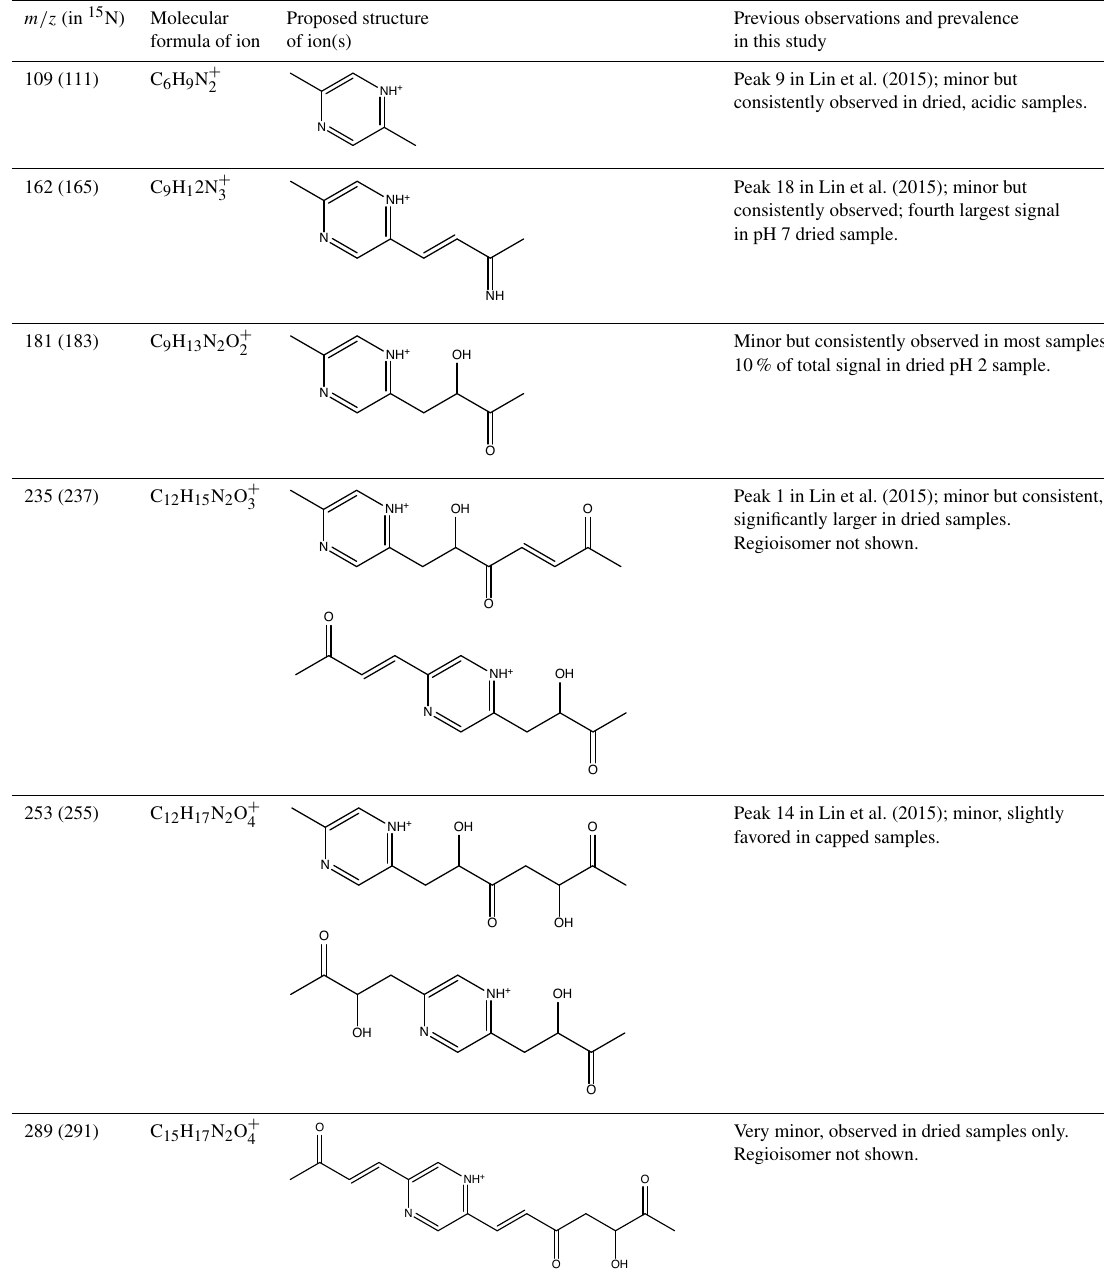
Table 3. Proposed structures for novel pyrazine-based chromophores matching the molecular weight and number of N atoms observed in this study. The observed m/z in 15 N samples is provided in parentheses. In some cases, the ion (but not the structure) was reported in a previous study. m/z (in 15 N) Molecular Proposed structure Previous observations and prevalence formula of ion of